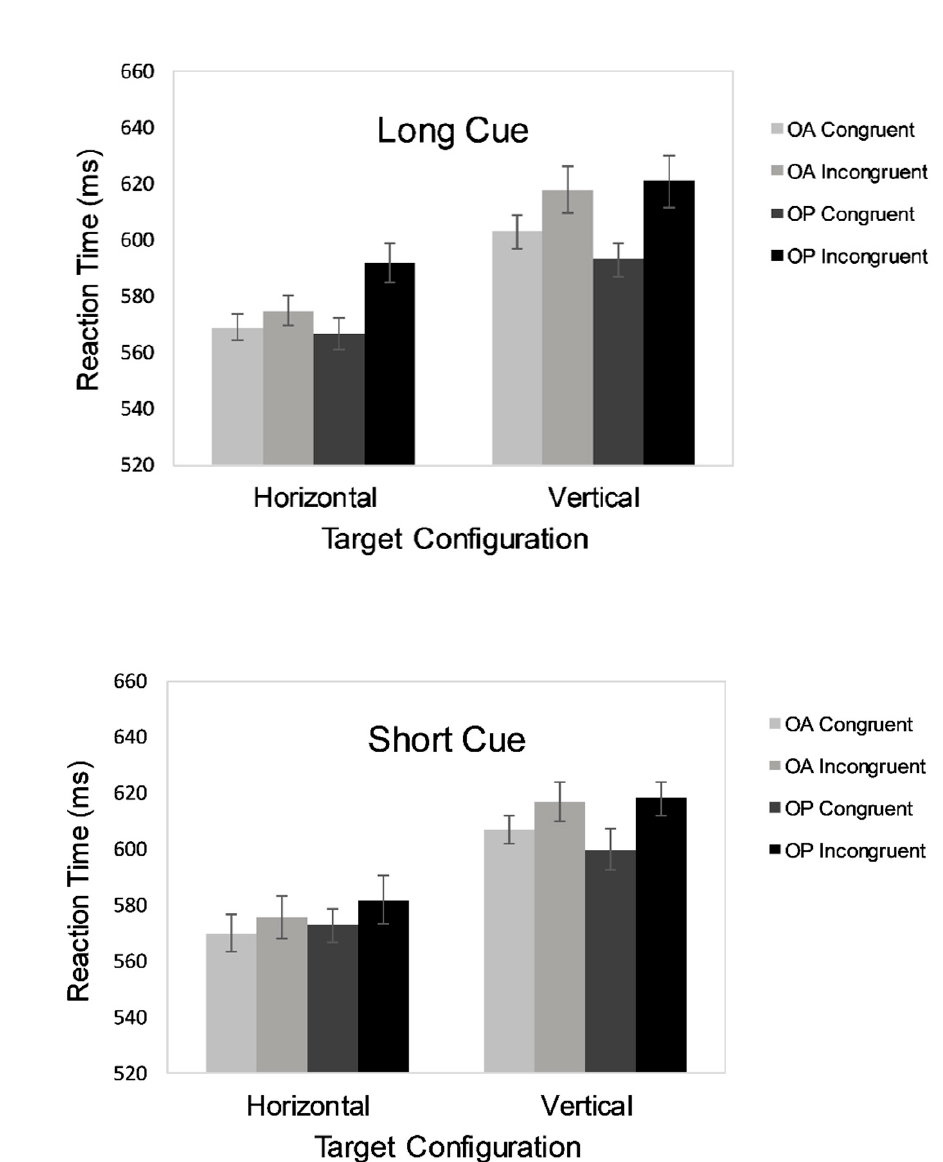
Figure 2. Mean Reaction time results from Experiment 1. ( A ) The long-cue condition, in which the cue was a long bar, and the subsequent targets appeared at the locations occupied by the cue on valid trials. ( B ) The short-cue condition, in which the cue was a short bar, and the subsequent targets appeared at the locations indicated, but not occupied, by the cue on valid trials. OA = object-absent trials; OP = object-present trials.